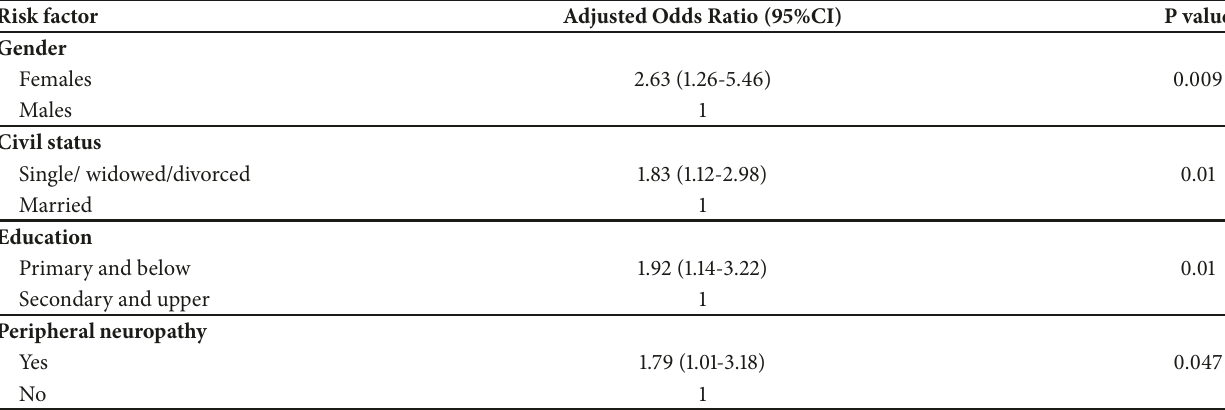
Table 4: Multiple logistic regression analysis showing the risk factors associated with